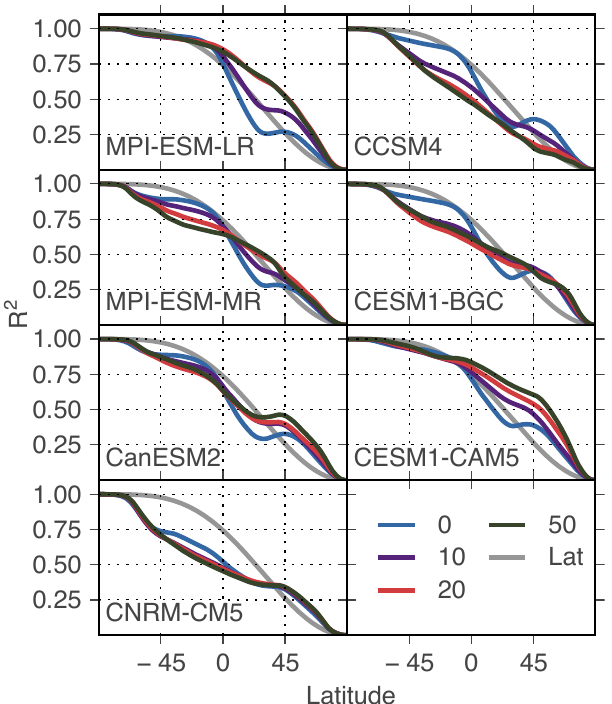
Fig. 4. Meridional dependence of the GMT variance. The horizontal averaged yearly SAT anomalies are integrated from 90 ◦ N southward. The value for a given latitude marks the explained variance ( R 2 ) of the GMT time series by the integrated SAT variance north of it. Colors indicate different low-pass filters applied. The grey line marks the variance contribution assuming equally distributed GMT variance. The explained variances of the unfiltered GMT signal that originates from north of 45 ◦ N are listed in Table 2.